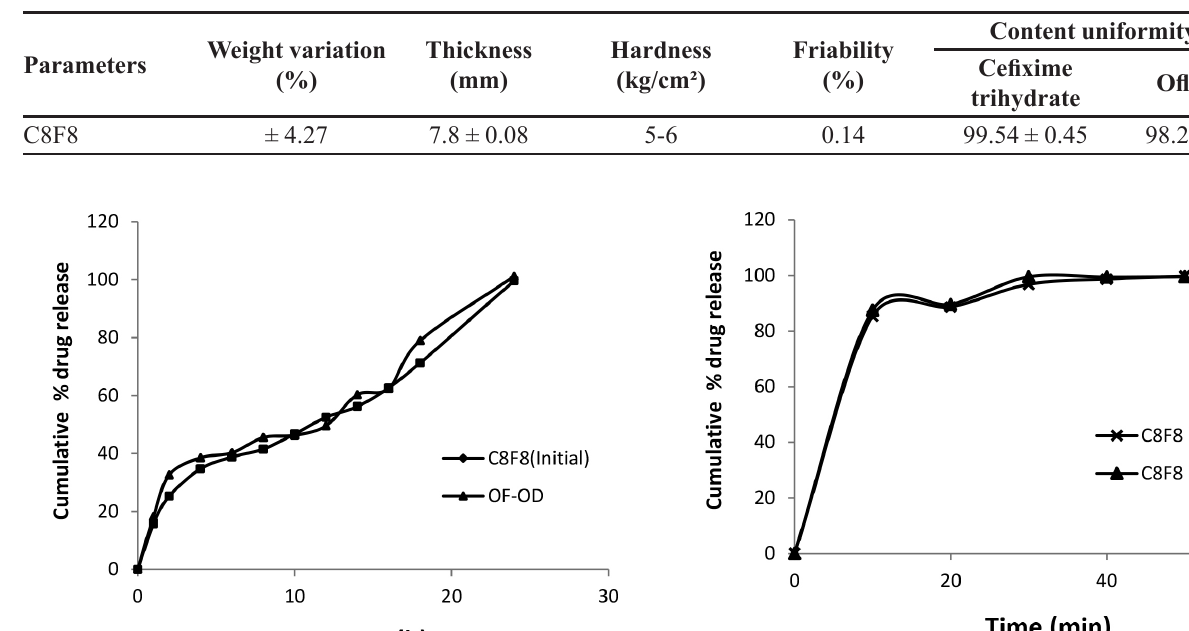
TABLE VI - Evaluation parameters of bilayer tablets